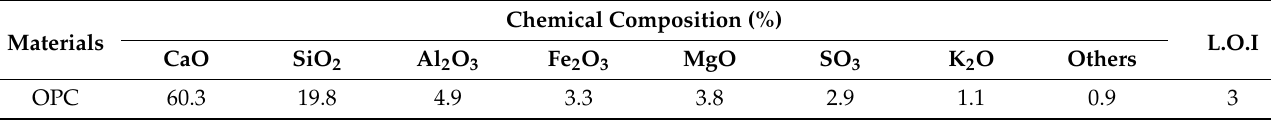
Table 3. Chemical properties of cement.